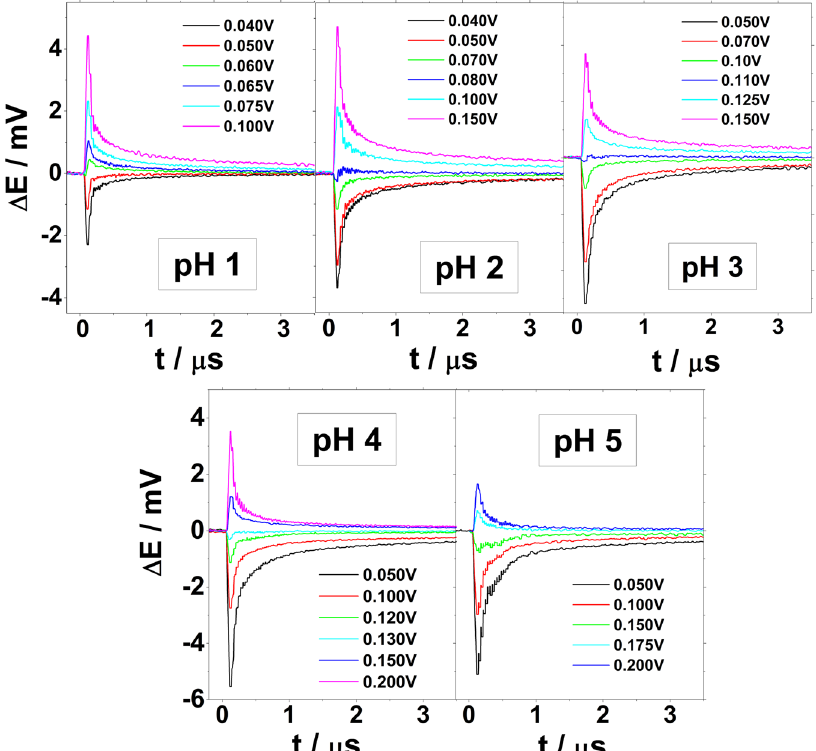
Figure 4. Laser-induced potential transients for Ir(111) at different pHs. Laser beam energy: 1 mJ/pulse. All the potentials are given versus the RHE scale. Composition of the electrolytes is the same as in Fig.